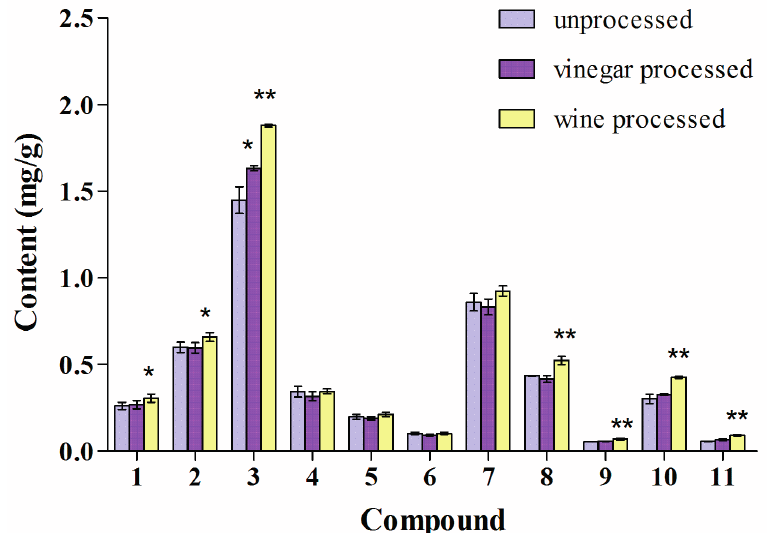
Figure 6. Alkaloid content of the water decoction of JLZS. Values are mean ± SD, n = 3, RSD < 10%. ** p < 0.01, * p < 0.05 of processed against unprocessed Corydalis